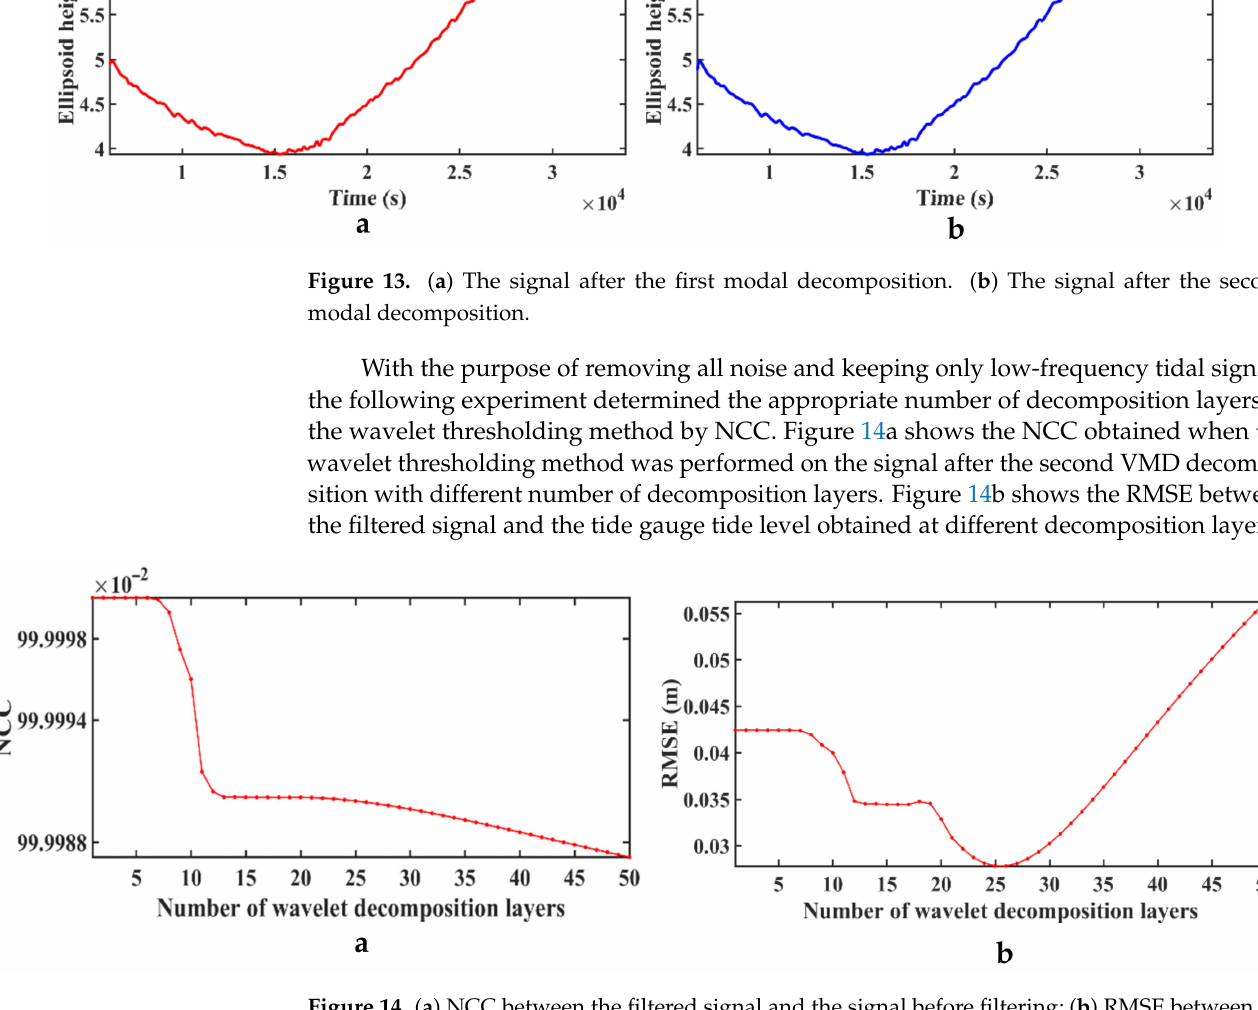
Figure 14. ( a ) NCC between the filtered signal and the signal before filtering; ( b ) RMSE between the filtered signal and the tide gauge tide